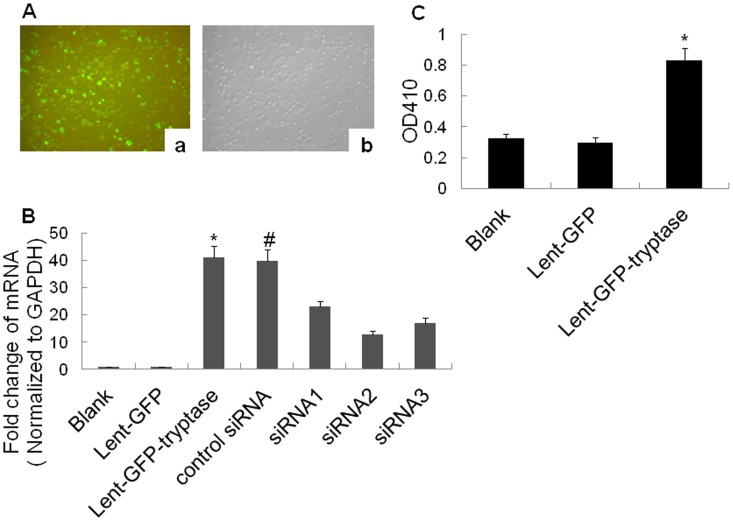
Constructions of tryptase lentivirus carrier and tryptase siRNA lentivirus carrier.A. Transfection efficiency detected by fluorescent microscopy. a. GFP-emitted green fluorescence. b. Same fields of vision under an optical microscope(×100). More than 80% cells were infected with lent-GFP at a dose of MOI 10 after 48 h treatment. B. Tryptase mRNA level by real-time PCR. The Lent-GFP-tryptase lentivirus significantly increased the tryptase mRNA level in the P815 cells. *P<0.01 vs. blank and Lent-GFP (n = 3). Additionally, siRNA2 plasmid decreased P815 cell tryptase expression at the mRNA level most significantly. *P<0.01 vs. siRNA2, #P>0.05 vs. Lent-GFP-tryptase (n = 3). C. Tryptase activity assay. The Lent-GFP-tryptase lentivirus increased tryptase activity in the P815 cell medium significantly. *P<0.01 vs. blank and Lent-GFP (n = 3).